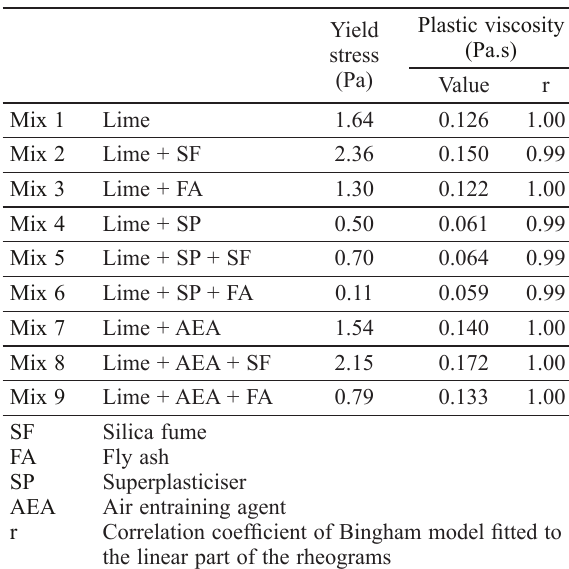
Table 5. Rheological properties of grouts